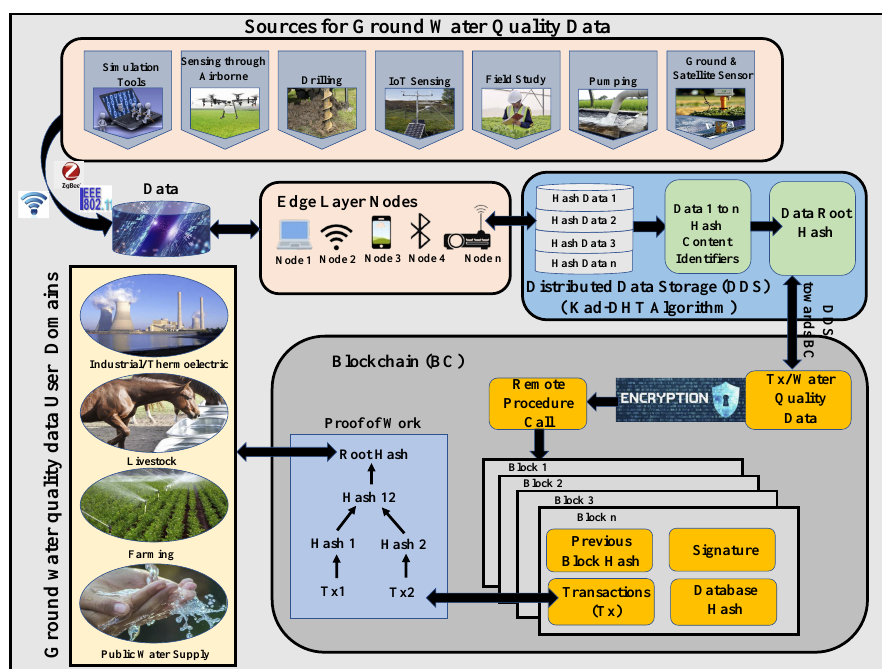
Figure 6. Proposed Blockchain Architecture for Groundwater Data Management with